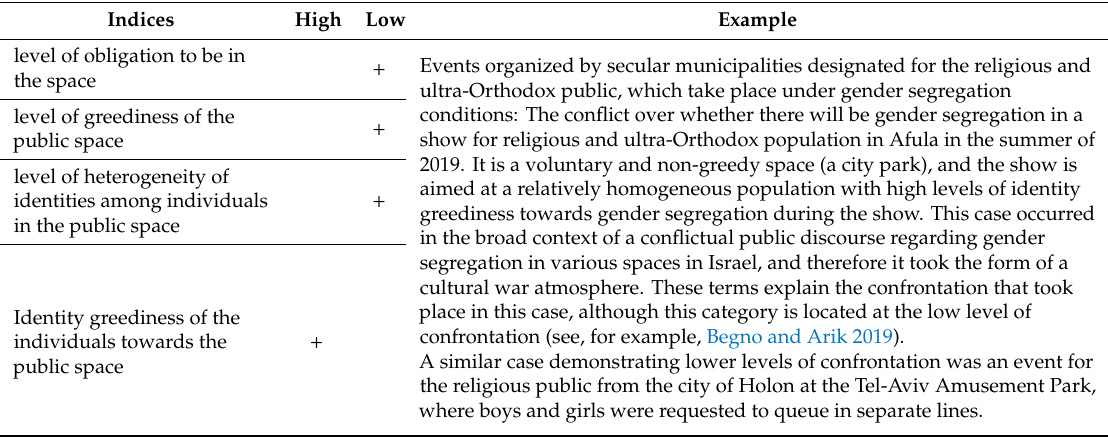
Table A7. Low potential confrontation.